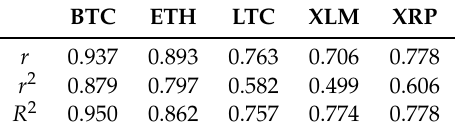
Table 6. Pearson’s correlation coefficient r , determination of coefficients r 2 of linear regression models between prices and volumes, and pseudo R 2 values from LOESS fit are provided in the